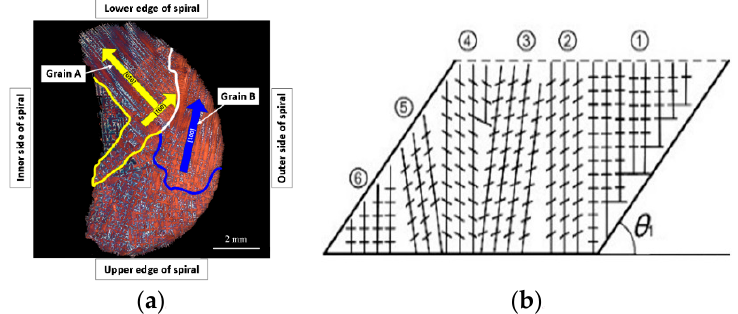
Figure 8. Schematic of grain selection mechanism of spiral part [6]. ( a ) secondary dendrite growth promoting effect in horizontal direction (named Effect 1) and ( b ) primary dendrite growth restraints effect in vertical direction (named Effect 2).